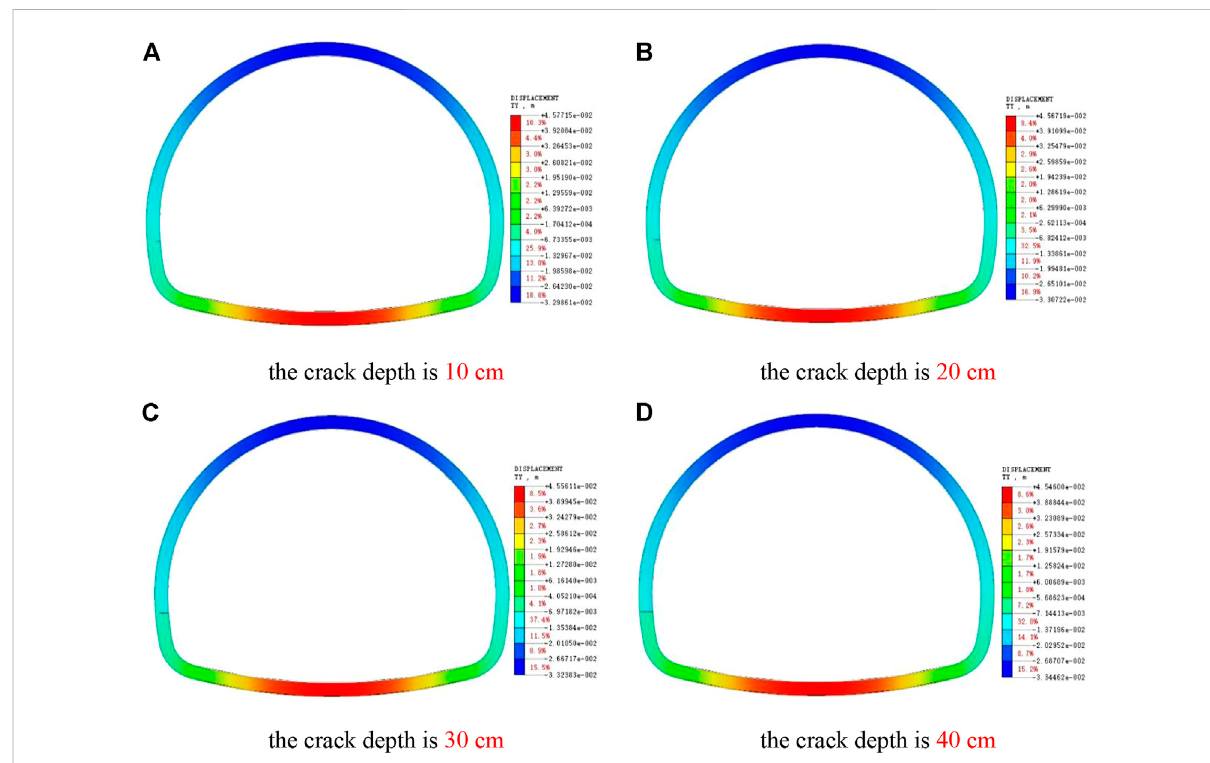
FIGURE 19 CloudpicturesofY-directiondisplacementofliningwithcracksatdifferentdepthsofsidewall. (A) Thecrackdepthis10 cm. (B) Thecrackdepth is 20 cm. (C) The crack depth is 30 cm. (D) The crack depth is 40